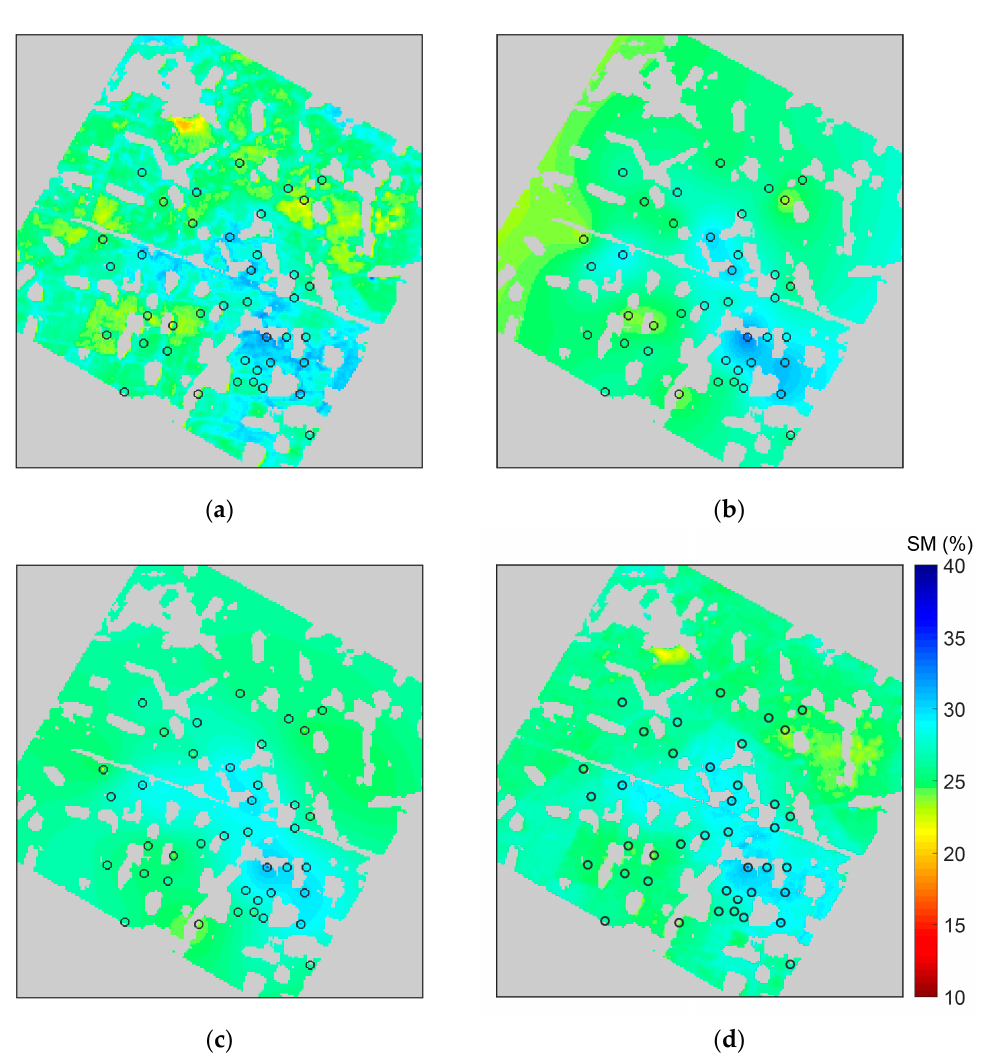
Figure 8. Interpolated soil moisture (SM) at depths of 10 cm on 10 July 2012, using WSN measured data: ( a – d ) are respectively the results of the Extended Kriging, OK, Co-kriging, and KED methods; the circles in maps represents the WATERNET nodes.